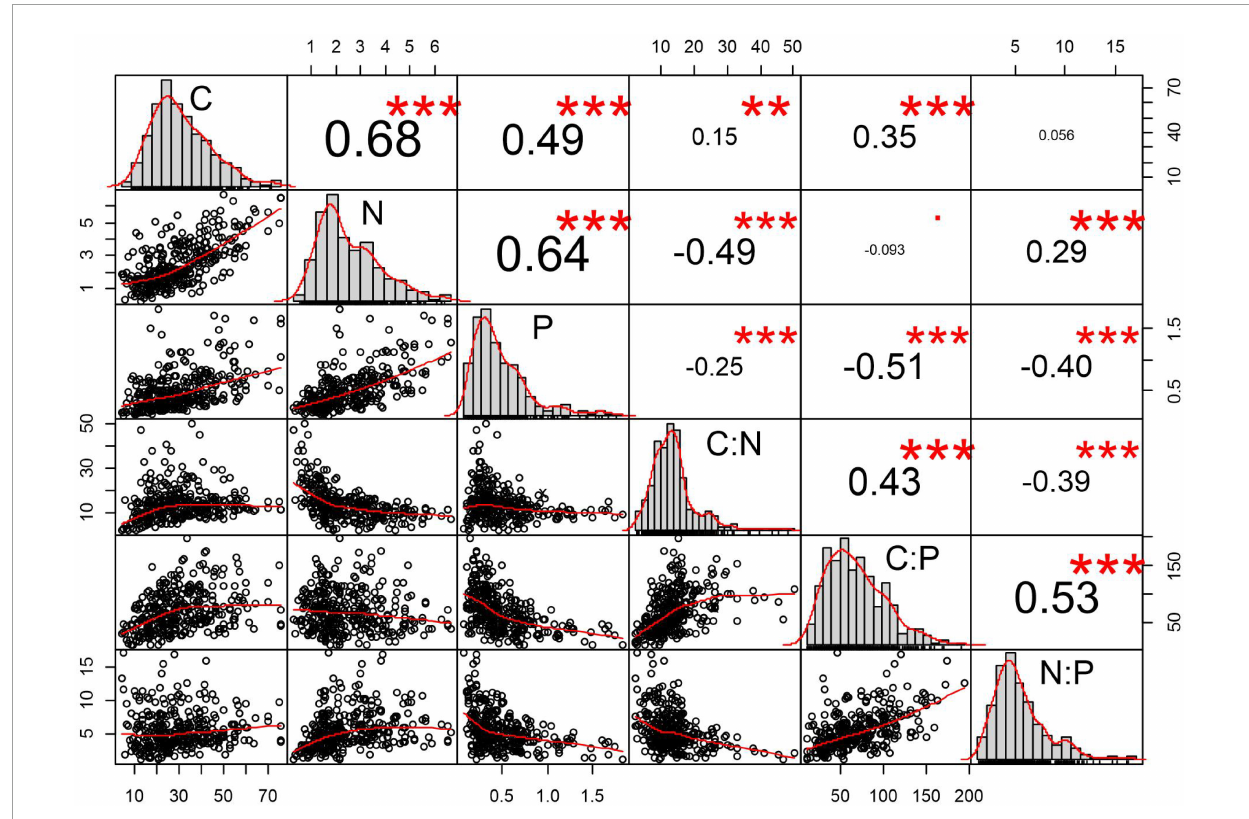
FIGURE2 Correlation coefficients of soil C, N, and P stoichiometry. ***Means P < 0.001, **means P <